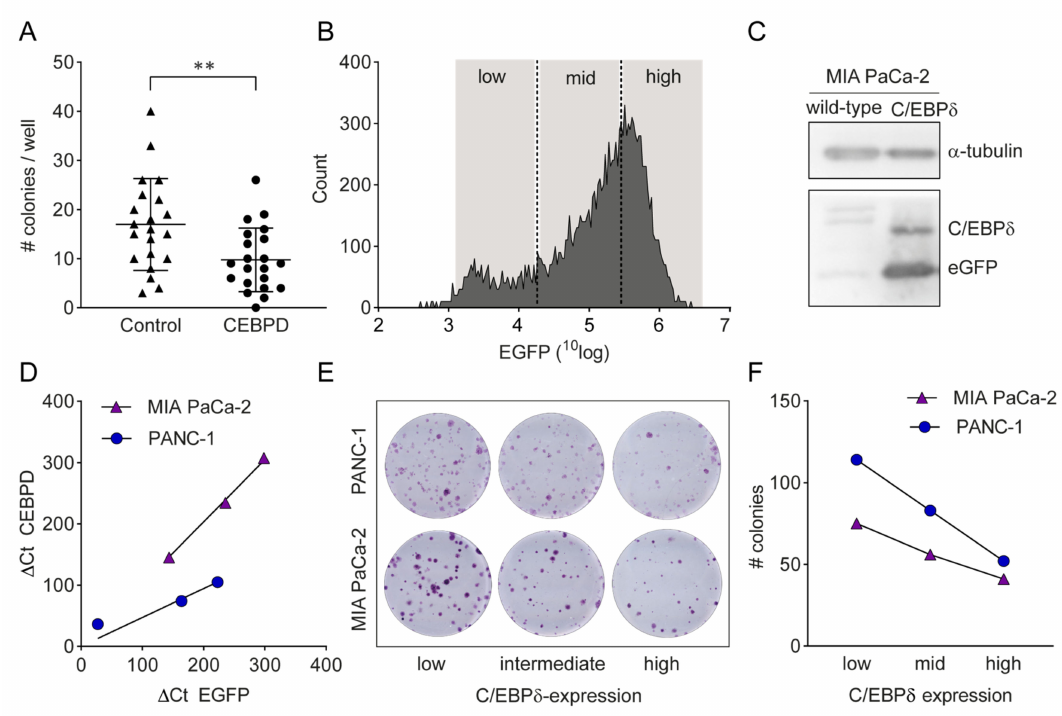
Figure 4. C / EBP δ over-expression inhibits clonogenicity in PANC-1 and MIA PaCa-2 cells. ( A ) Average number of colonies grown out from 100 C / EBP δ -over-expressing or control-transfected PANC-1 cells per well in three independent experiments ( N = 21). Lines indicate the mean ± SEM. ** p < 0.005. Out of 2100 control-transfected cells, 356 grew into a colony. Only 205 out of 2100 C / EBP δ over-expressing cells grew out a colony. ( B ) Histogram and gating of CEBPD- IRES -EGFP -transduced MIA PaCa-2 cells. ( C ) Western blot showing over-expression of C / EBP δ and eGFP protein after transfection. The uncropped blots are provided in Figure S2. ( D ) CEBPD and EGFP mRNA expression of CEBPD -IRES- EGFP -transduced cells sorted by EGFP-fluorescence. Quantitative RT-PCR confirmed elevated CEBPD mRNA expression in cells expressing high EGFP mRNA (MIA PaCa-2: R 2 = 0.9975, * p < 0.05; PANC-1: R 2 = 0.9724, p = 0.0531). ( E ) Clonogenic assay of PANC-1 and MIA PaCa-2 cells expressing C / EBP δ at varying levels. ( F ) C / EBP δ expression correlates with colony formation e ffi ciency. Plotting the number of colonies from e ffi ciency on CEBPD levels in PANC-1 and MIA PaCa-2